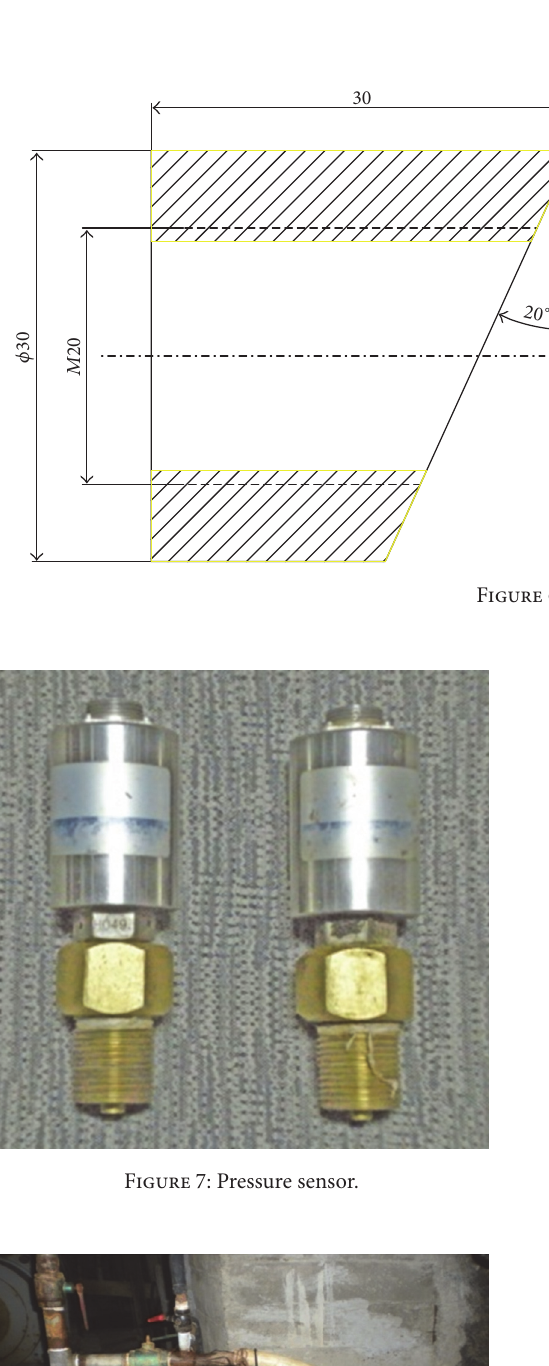
increase of the pump flow. By comparison, the test results